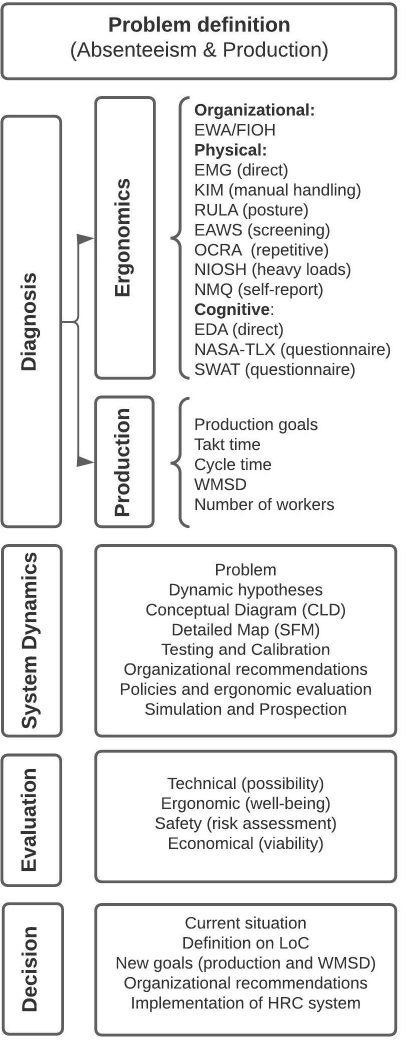
Figure 3. Phases of the developed framework.